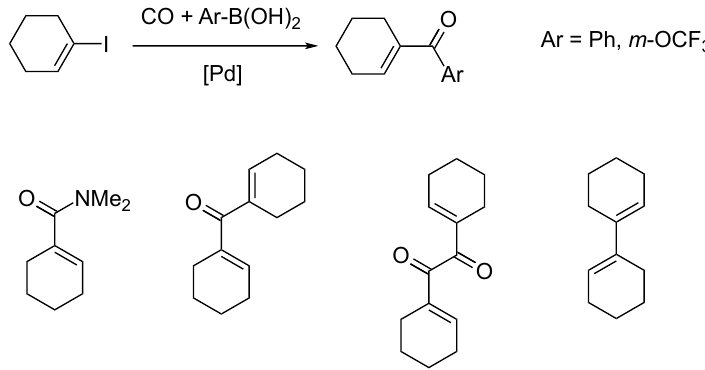
Figure 4. Carbonylative Suzuki-Miyaura reaction and its products. In a two-step reaction sequence, various primary amides and ketoamides were pre- pared. The first step involved palladium-catalyzed aminocarbonylation of iodoalkene and iodoarene substrate with tert-butylamide. The resulting amides and ketoamides were reacted with tert-butyldimethylsilyl triflate (TBDMSOTf) for the cleavage of the t Bu group, affording primary amides [38]. Ortho-alkoxy aryl iodides (2-iodoanisole, 5-chloro-7-iodo-8-methoxy-quinoline, and 5-chloro-7-iodo-8-benzyloxy-quinoline) were aminocarbonylated in the presence of in situ produced Pd(0) catalysts and simple primary and secondary amines. The chemoselectivity was shifted towards the formation of ketoamides when the CO pressure was increased to 40 bar [39].